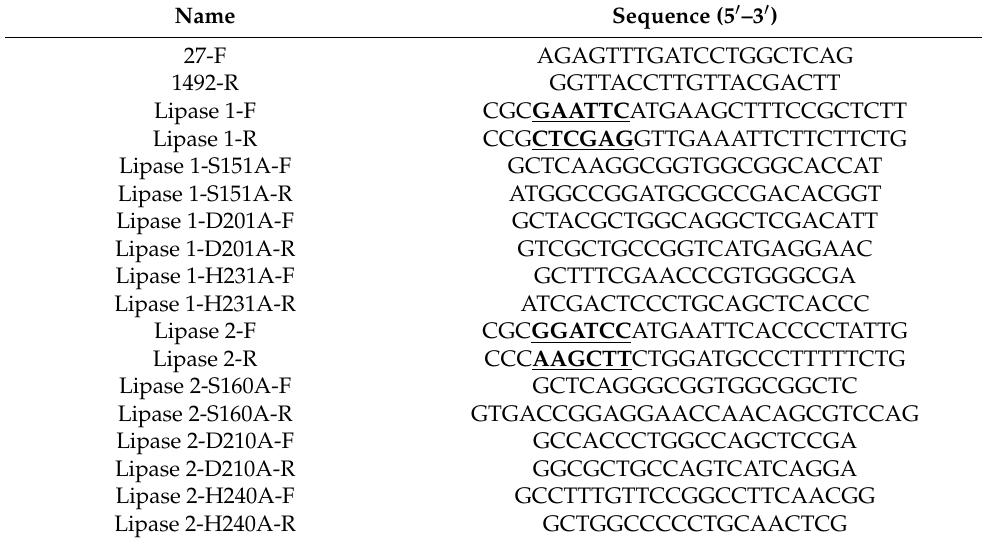
Table 1. Primers used in this